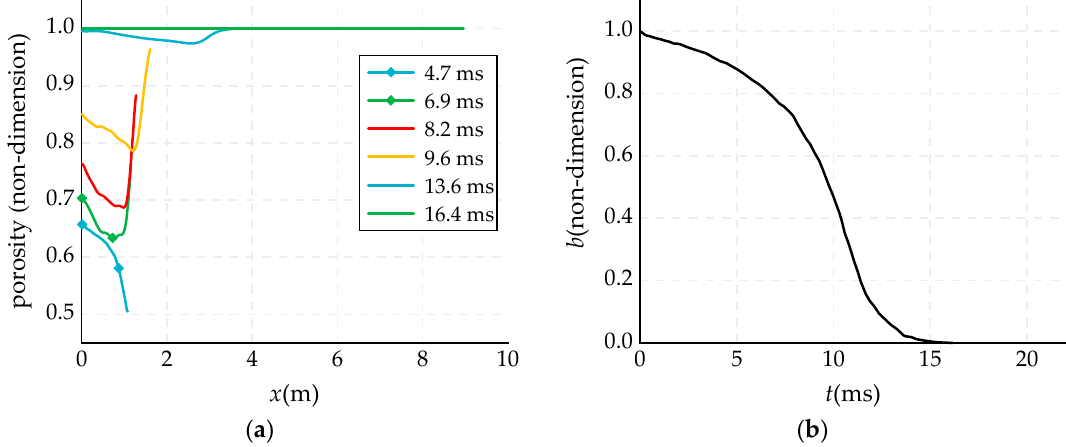
Figure 11. ( a ) Porosity distribution, ( b ) percentage of uncombusted propellant energy.